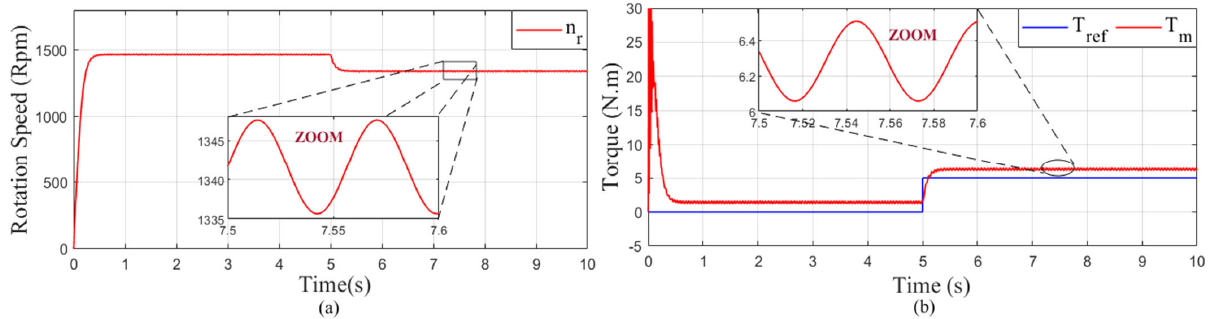
Figure 18. Performance with Cage bearing defect of IM without control: ( a ) rotation speed and ( b ) motor torque.